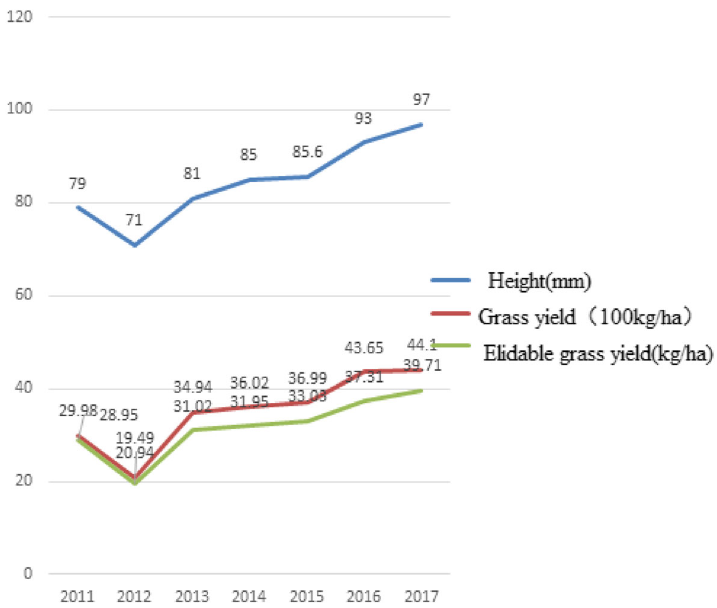
Fig. 3 Grassland recovery conditions in Tianjun (2011 – 2017). Source: Tianjun County Environmental Protection